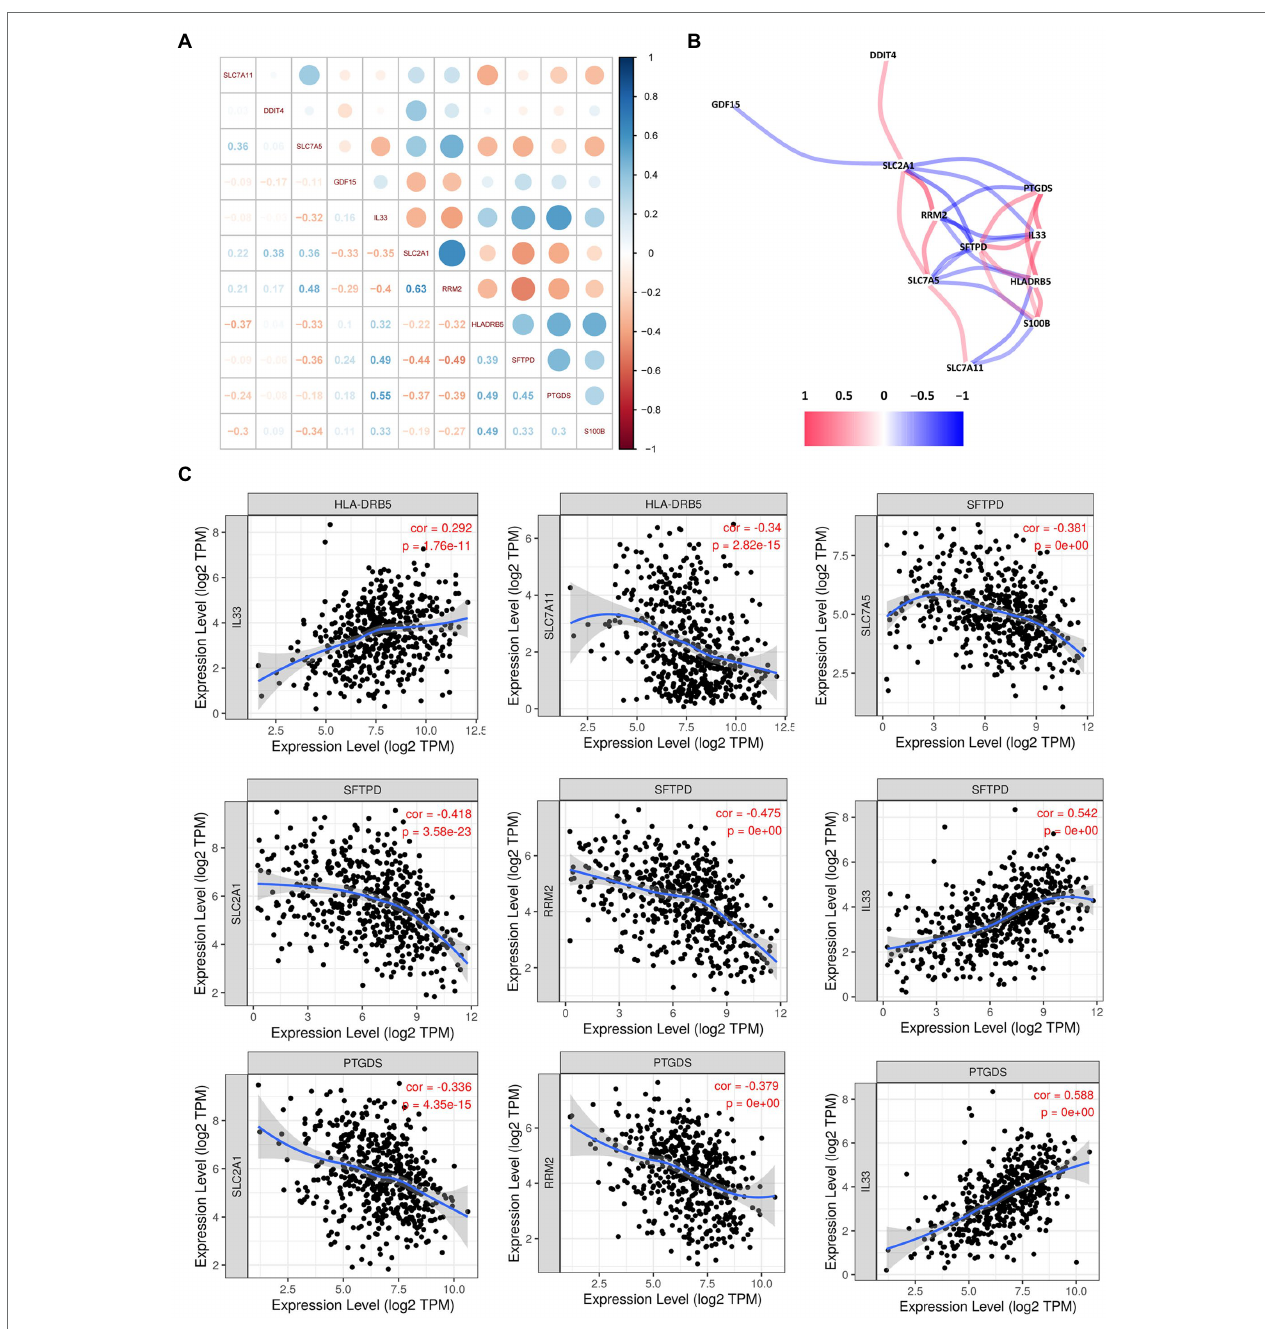
FIGURE 7 | Correlation analysis among the hub genes. (A) Correlation diagram of the likely relationships among the hub genes. (B) Correlation network of the hub genes. (C) Association between the expression levels of hub